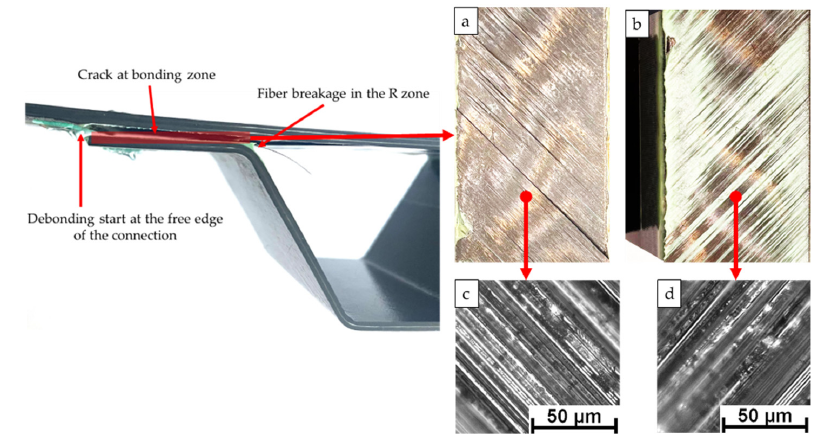
Figure 8. ( a – d ) Failure modes and fracture surfaces of the static tests.